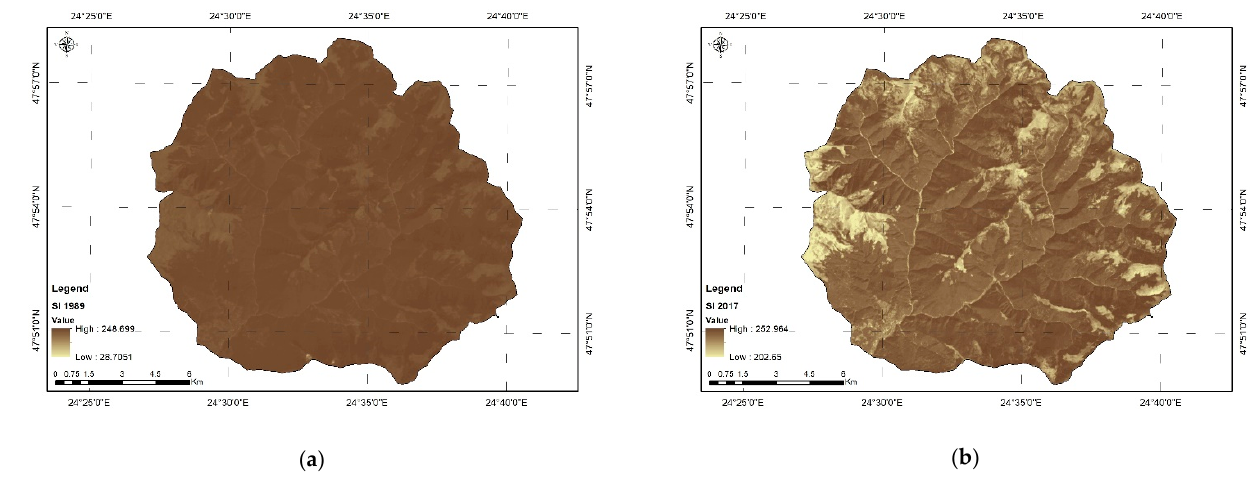
Figure 6. Shadow index (SI). ( a ) SI for year 1989; ( b ) SI for year 2017. Thermal Index (TI). This index was developed considering that bare surfaces (without vegetation) have a higher temperature at ground level than shaded surfaces in areas covered by forests [33]. This indicator allows distinguishing between the shaded slopes with forests and the shaded slopes without forests.